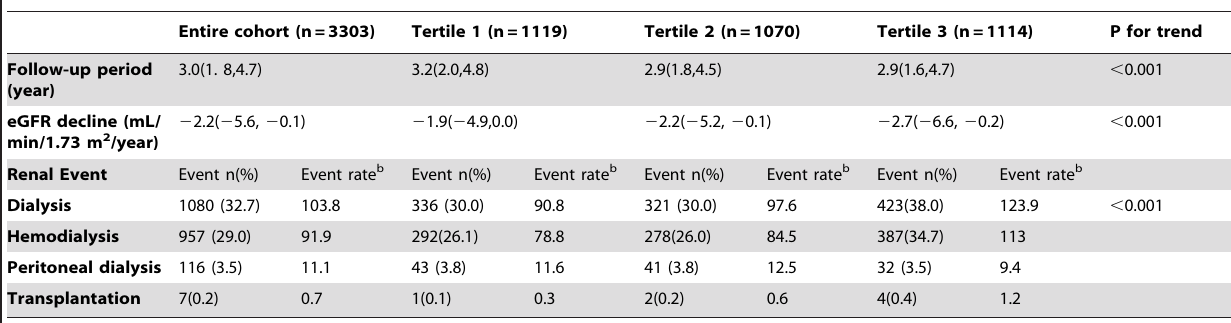
Table 2. Renal event and eGFR decline of hs-CRP tertiles a .